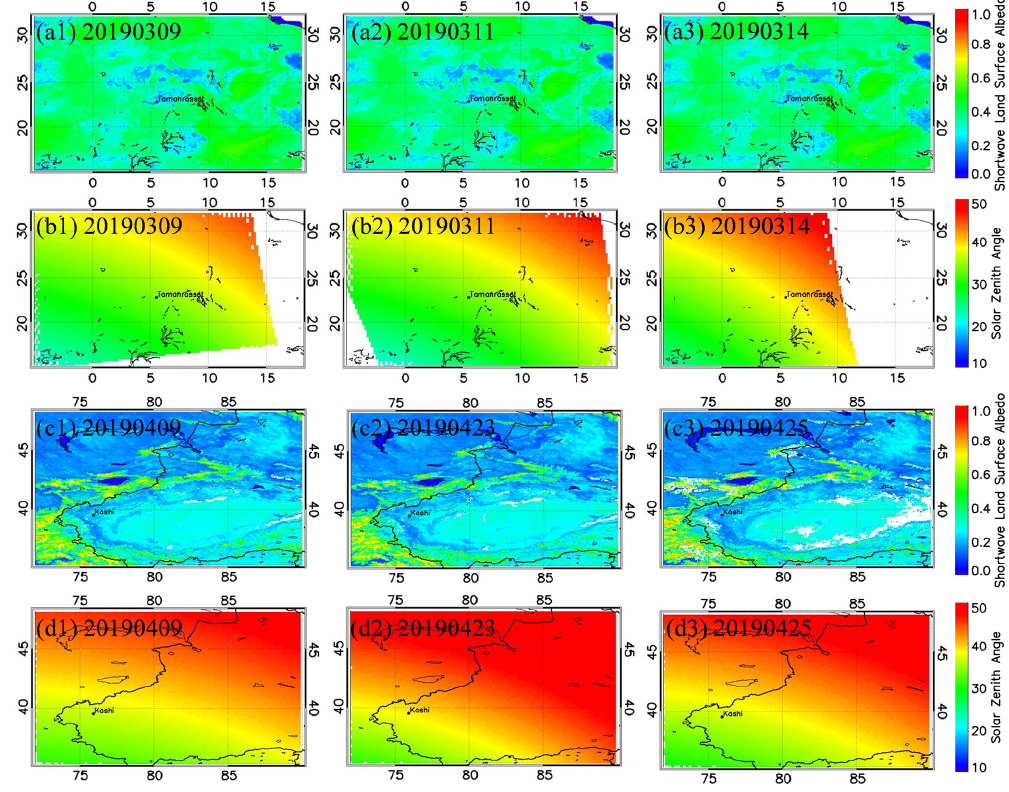
Figure 3. SW LSA and SZA over the Sahara and Taklimakan Desert derived from